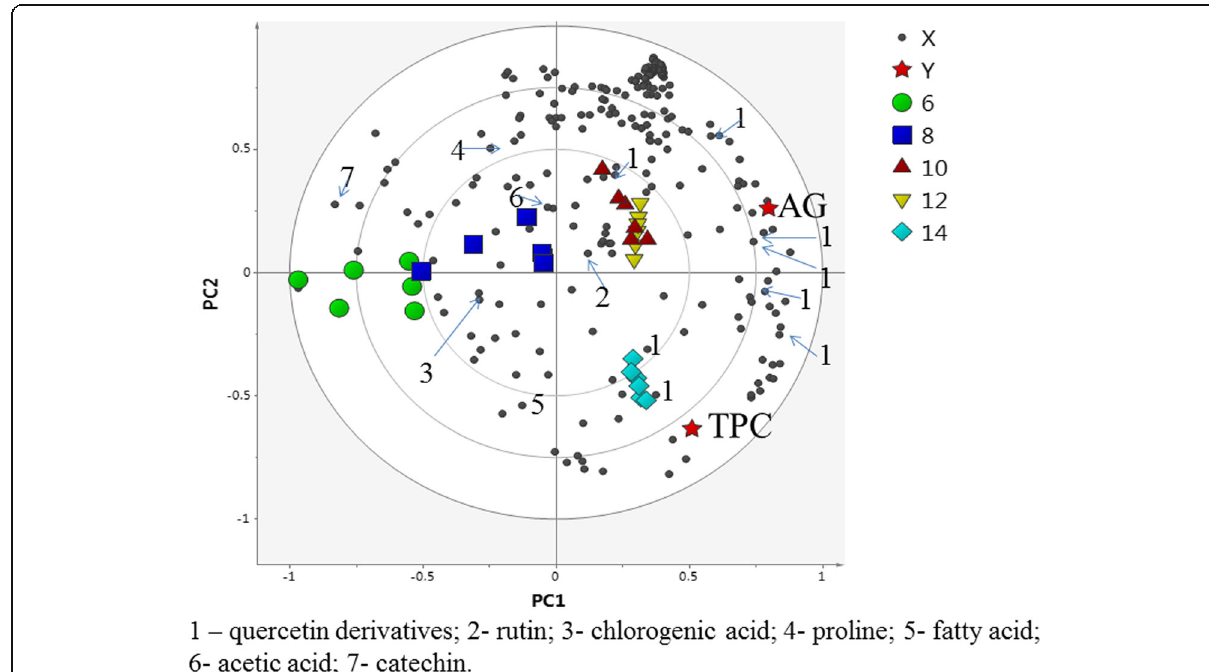
Fig. 6 The biplot obtained from PLS describing the variations between the different harvesting ages of C. caudatus and the correlation between the metabolites in the extracts with TPC and α -glucosidase inhibitory activity. The following compounds contribute to the separation. 1 – quercetin derivatives; 2 - rutin; 3 - chlorogenic acid; 4 - proline; 5 - fatty acid; 6 - acetic acid; 7 –